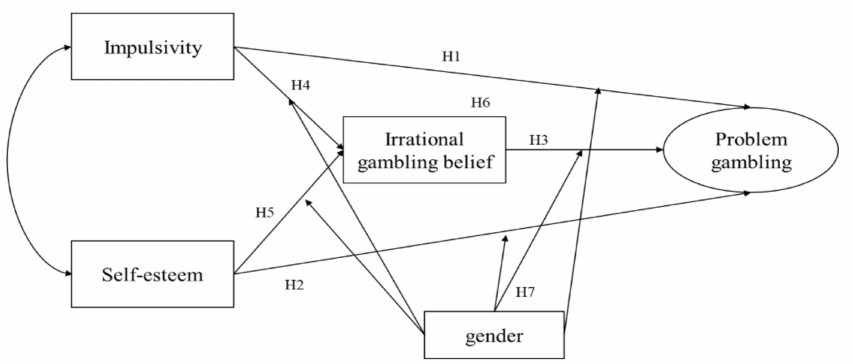
Figure 1. Research